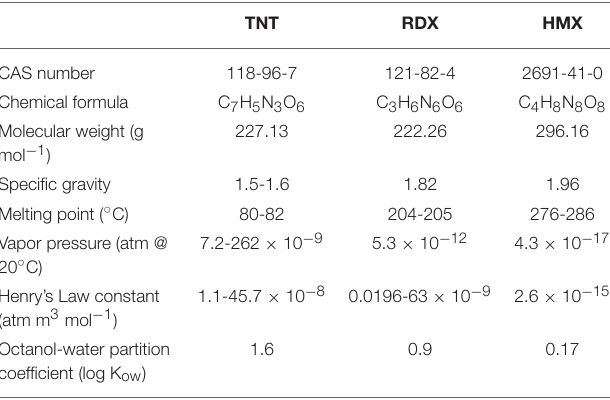
TABLE 1 | Physicochemical properties of TNT, RDX, and